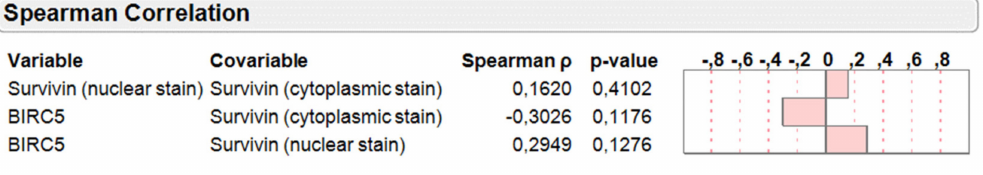
Figure 3. Spearman correlation of IHC staining and semi-quantitative assessment of survivin protein located in cytoplasmic versus nuclear localization with quantitative BIRC5 (survivin) mRNA levels in the combined PCR and IHC cohort ( n = 28). Graphical display of Spearman rho values and respective p -values are